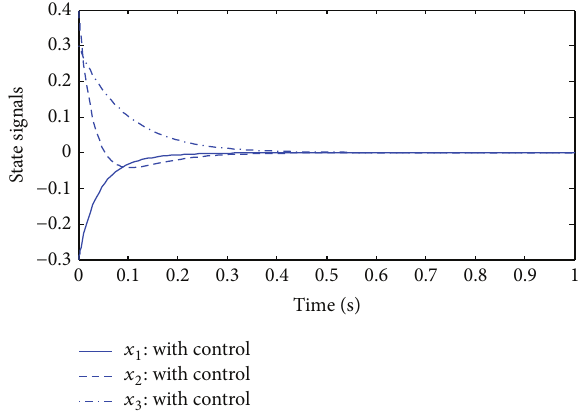
Figure 4: Transient response of state signals with 𝐾 = diag (−20 −20 −10)